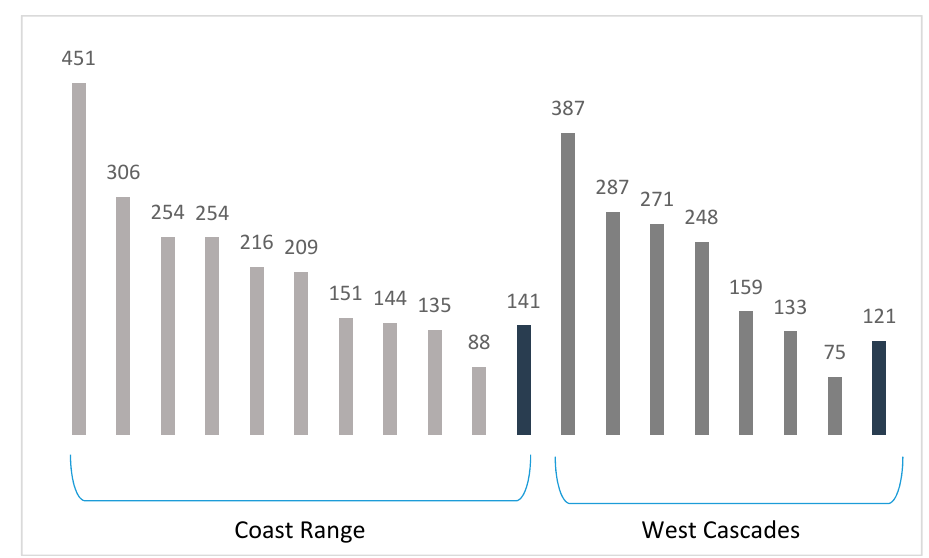
Figure 7. mtCO 2 e/acre measured in 2017 on 17 private non-industrial forestland in Oregon compared to California Air Resource Board regional baselines (in black).